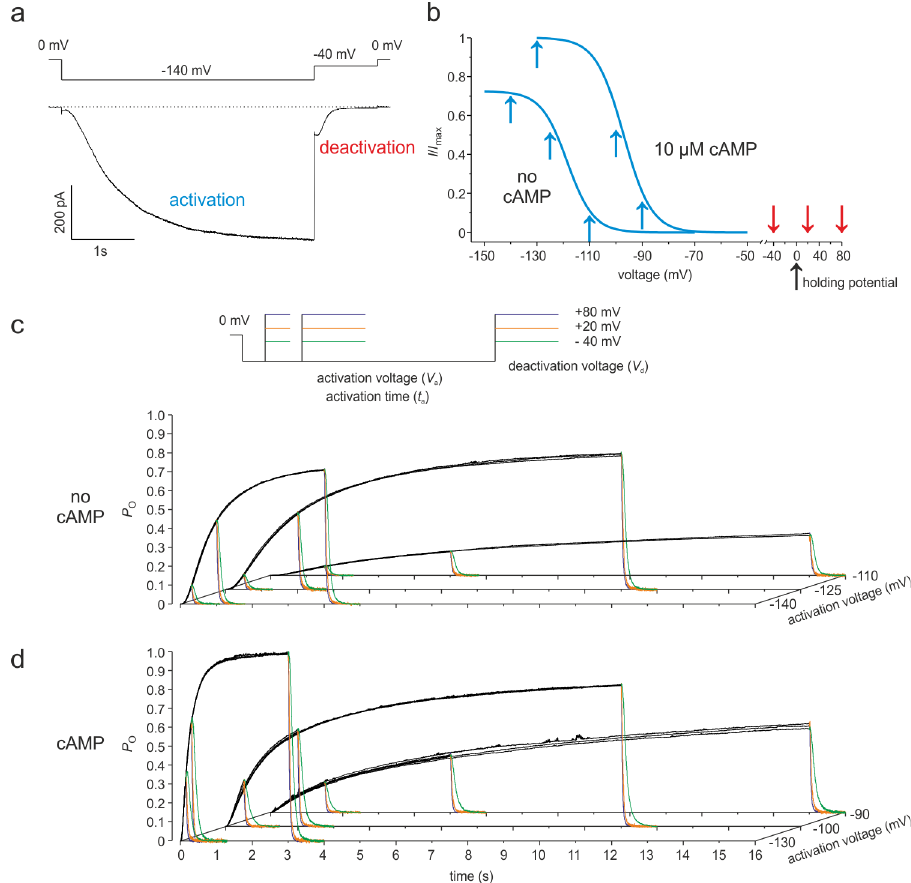
Fig 1. Multiple time courses of P o covering a wide voltage range for HCN2 channel gating. Currents were activated by hyperpolarizing pulses to the voltage V a with the duration t a followed by depolarizing pulses to the voltage V d to generate deactivation. ( a ) Representative current trace. V a = - 140 mV, t a = 4 s, V d = -40 mV. ( b ) Steady-state activation in the absence of cAMP and in the presence of 10 μ M cAMP. The Boltzmann curves, obtained with pulses of 4 s duration, were computed according to a previous report by equation S1 [47]. The values were: no cAMP: z = 5.15, V h = -118.4 mV; 10 μ M cAMP: z = 4.88, V h = -97.1 mV. The blue and red arrows indicate the used values of V a and V d , respectively. ( c ) Set of P o traces following 27 different double pulse protocols in the absence of cAMP. V a = -140 mV: t a = 0.3 s, 1 s, 4 s; V a = -125 mV: t a = 0.5 s, 2 s, 11 s; V a = -110 mV: t a = 1.5 s, 5 s, 15 s (n = 5–18). ( d ) As c but in the presence of cAMP. V a = -130 mV: t a = 0.15 s, 0.3 s, 3 s; V a = -100 mV: t a = 0.5 s, 2 s, 11 s; V a = -90 mV: t a = 1.5 s, 5 s, 15 s. In c and d